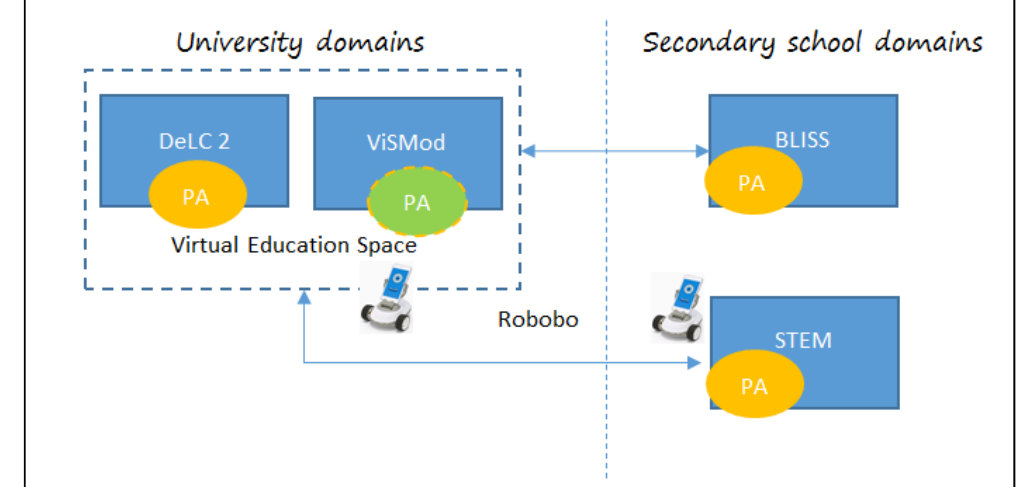
Figure 10. ViToS Architecture.